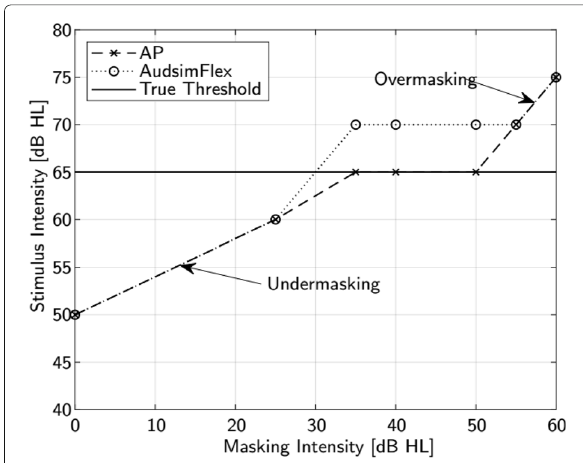
Fig. 5 Behavior of the AP in air-conduction testing with masking